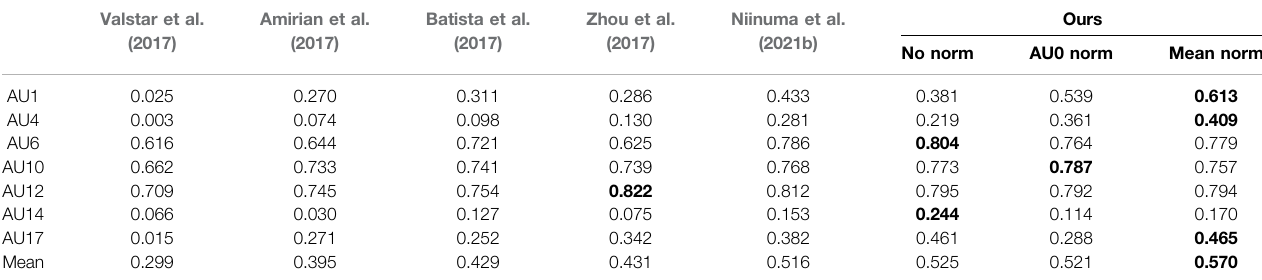
TABLE 4 | Comparison with state-of-the-art methods on FERA 2017 Test partition. Reported scores are ICC on frontal views only. The results for No norm is the same with the ones for 3D Synthetic in Table 2 . Valstar et al. (2017)